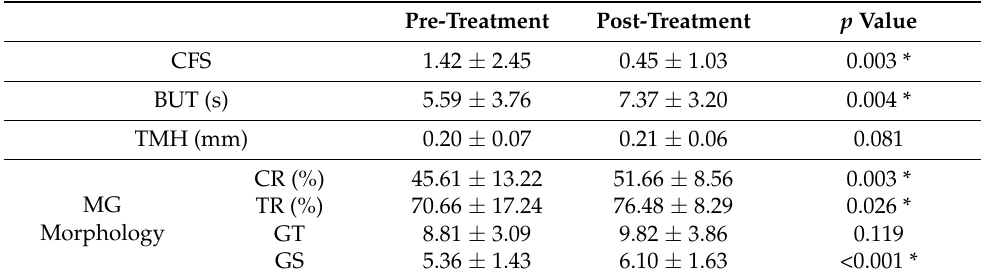
Table 1. Patient data of ocular-surface indexes before and after